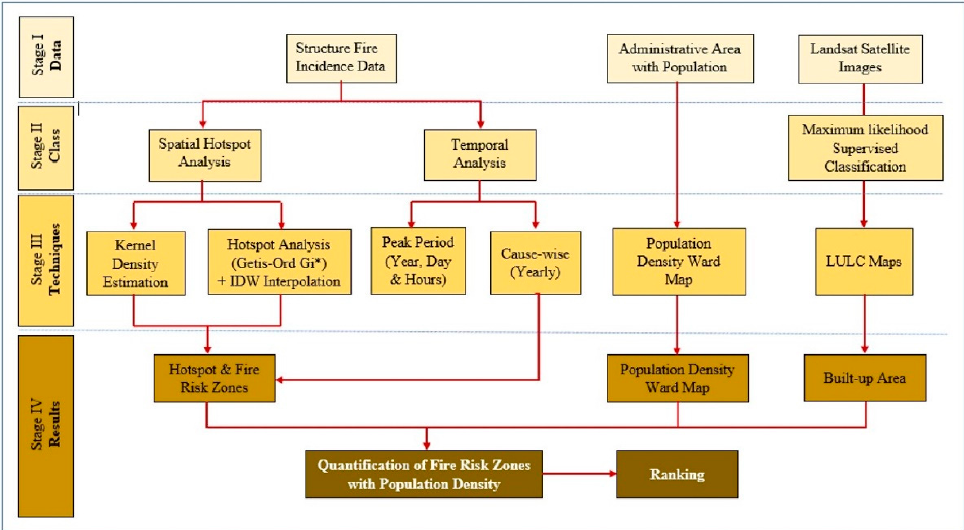
Figure 3. Methodological flow chart of the study .